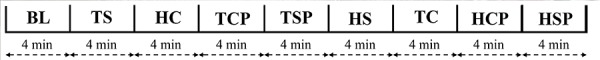
An example session protocol. BL, baseline; T, town; H, highway; C, clear weather; S, snowy weather; P, using cell phone; without P, no cell phone. The eight scenarios after the baseline were presented in random order, and the presented example is only one of the possible orders.